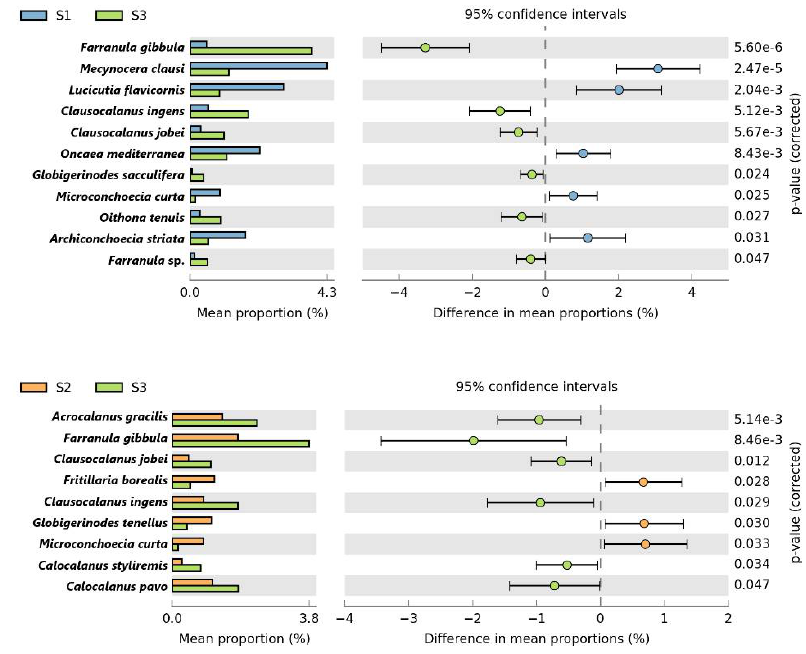
Figure 8. Analysis of species abundance differences between equatorial sections (S3) and two latitudinal sections (S1 and